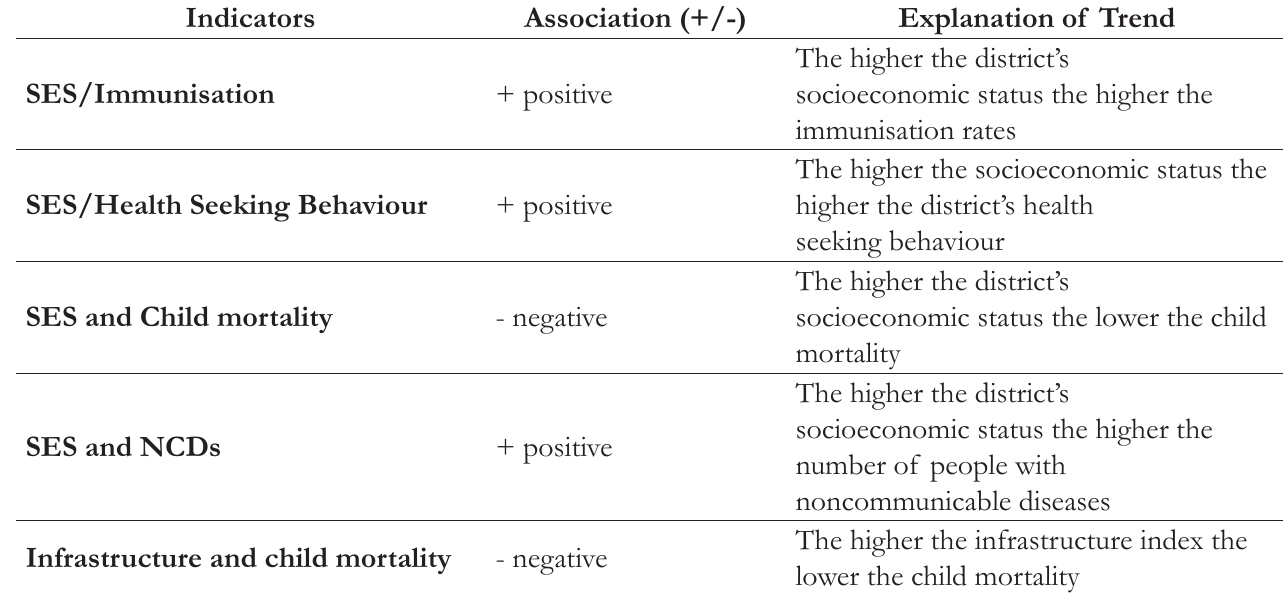
Table 5. Relationship between Selected